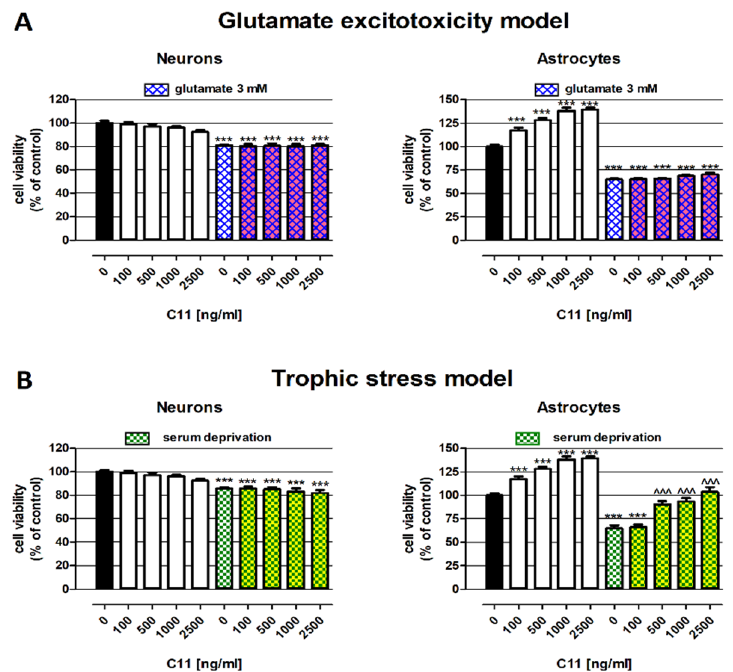
Figure 1. Impact of C11 on the viability of neurons and astrocytes under standard or degenerative conditions: ( A ) glutamate excitotoxicity and ( B ) trophic stress. Cells were exposed for 48 h to the